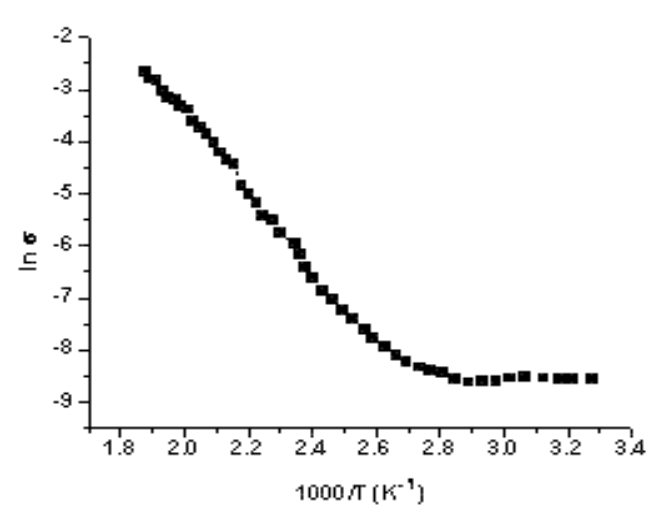
Figure 6. ln σ vs.1000/T of ZnTTBPc thin films.